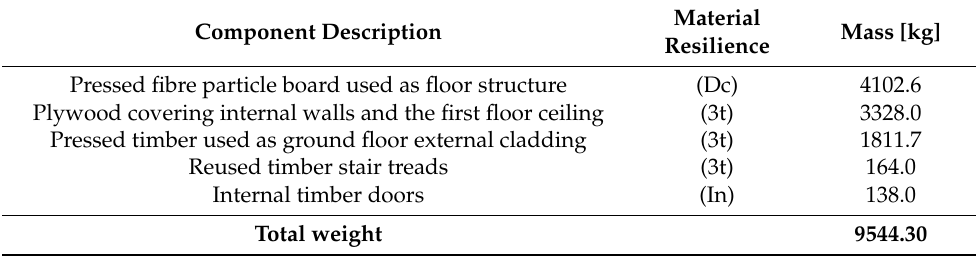
Table 2. Timber components used in the L3 case study and their resilience metric. In = reusable infinite times, 3t = reusable up to three times, and Dc =